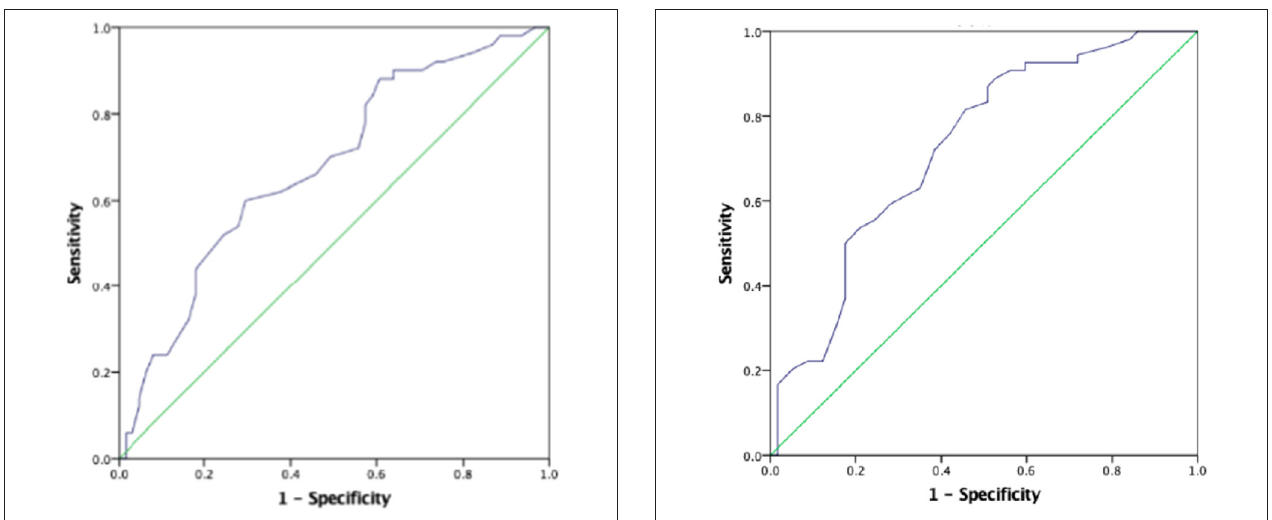
FIGURE 1 | The role of prenatal first systolic blood pressure (SBP) in predicting low birth weight. The receiver operating characteristic (ROC) curve illustrates prenatal first SBP. Areas under the curves (AUCs) are 0.676 (95% CI 0.618–0.733, p < 0.001) for the prenatal first SBP. A cut-off valuable of 121.5 mmHg yielded good sensitivity and specificity. The sensitivity and specificity are 88 and 60.7%, respectively.